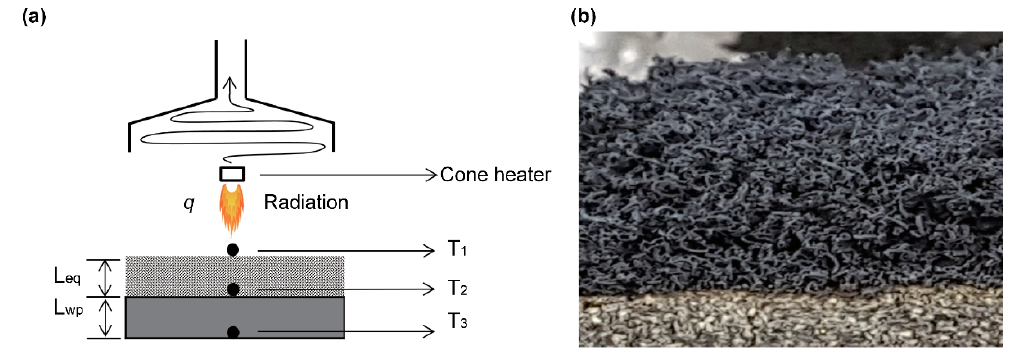
Figure 11. Variations in total heat released (THR) with expandable graphite content.